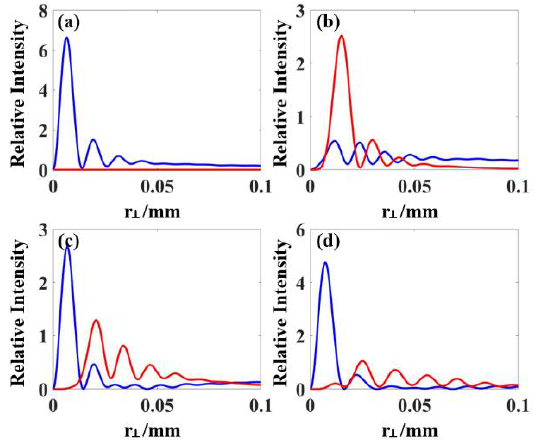
Figure 3. The relative intensity | E + ( r ⊥ , φ , z f )| 2 /max [| E ( r ⊥ , φ , 0)| 2 ] (blue line) and | E − ( r ⊥ , φ , z f ) | 2 /max [| E ( r ⊥ , φ , 0)| 2 ] (red line) on the r ⊥ axis under ( a ) L = 0 mm, ( b ) L = 10 mm, ( c ) L = 20 mm and ( d ) L = 30 mm.